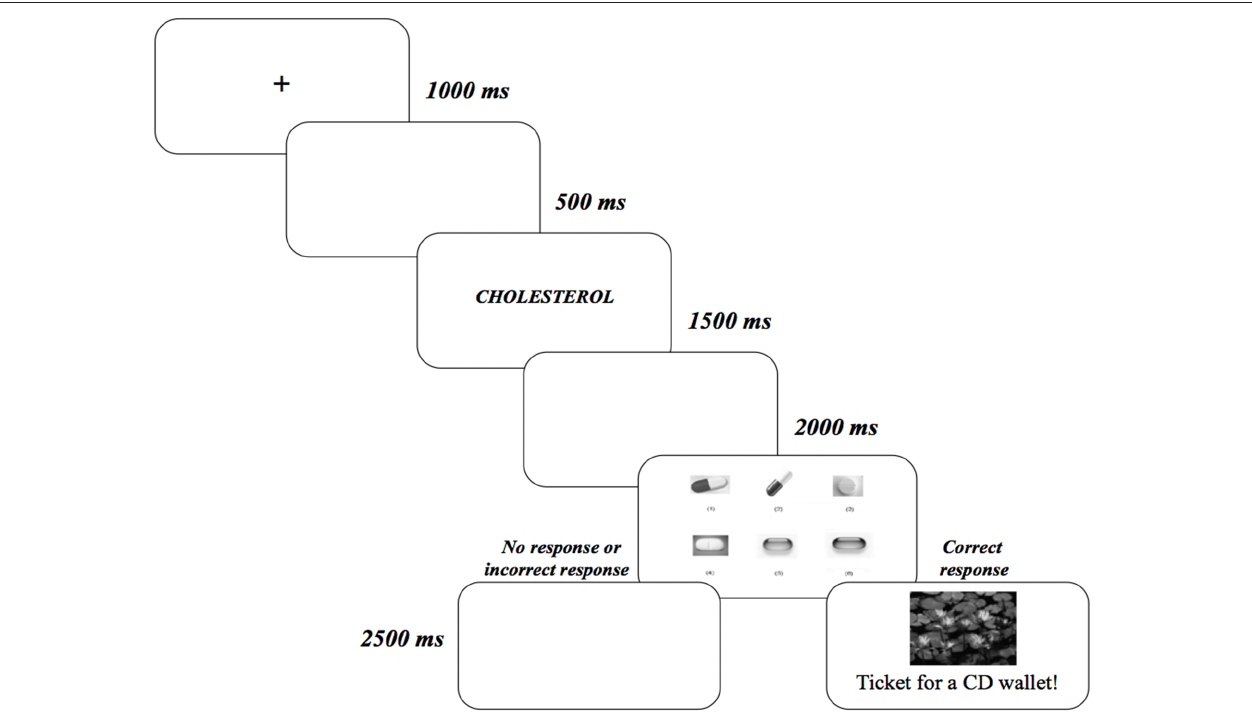
FIGURE 1 | Stimulus sequence (from left to right) used in Experiments 1A and 1B. Participants were required to choose the pill (comparison stimulus) that was associated with the disorder (sample